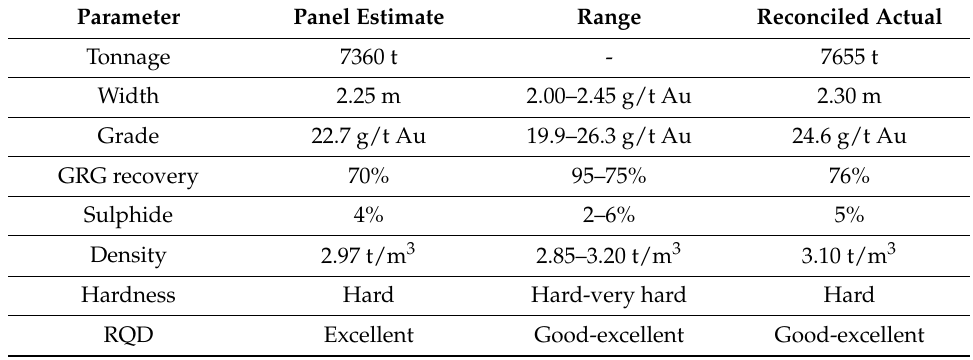
Table 26. Example of stope panel data at the ore control model stage and post-mining